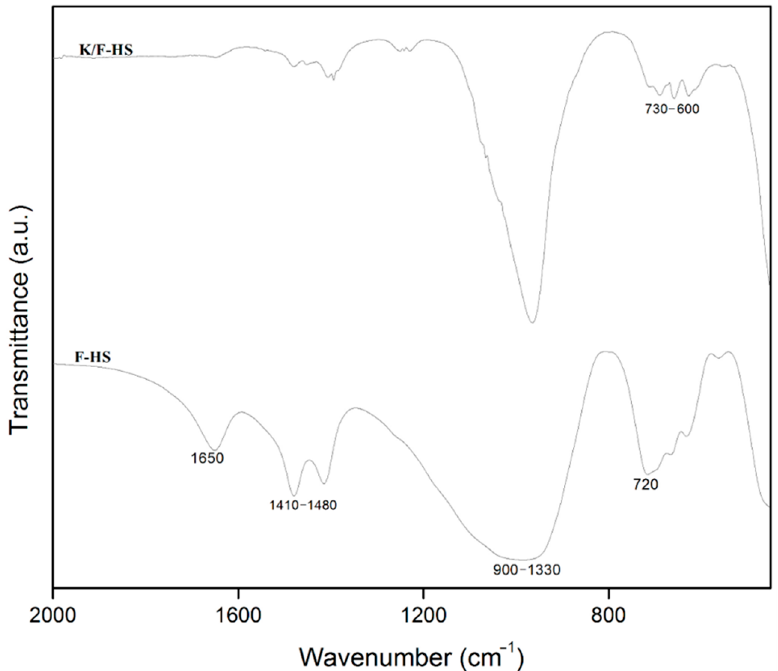
Figure 3. The FT-IR spectra illustrating the effect of ion exchange post-modification on indirect fu- sion HS zeolite. HS